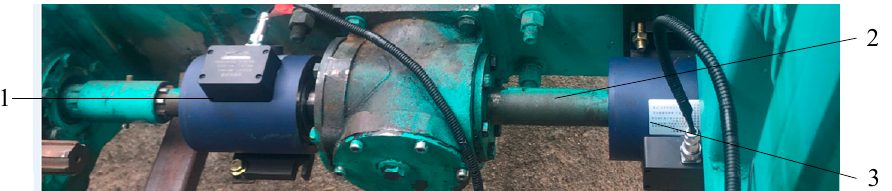
Figure 1. Physical view of header power sensor. 1: power sensor of inside shaft 2: T-type drive shaft 3: power sensor of outside shaft.